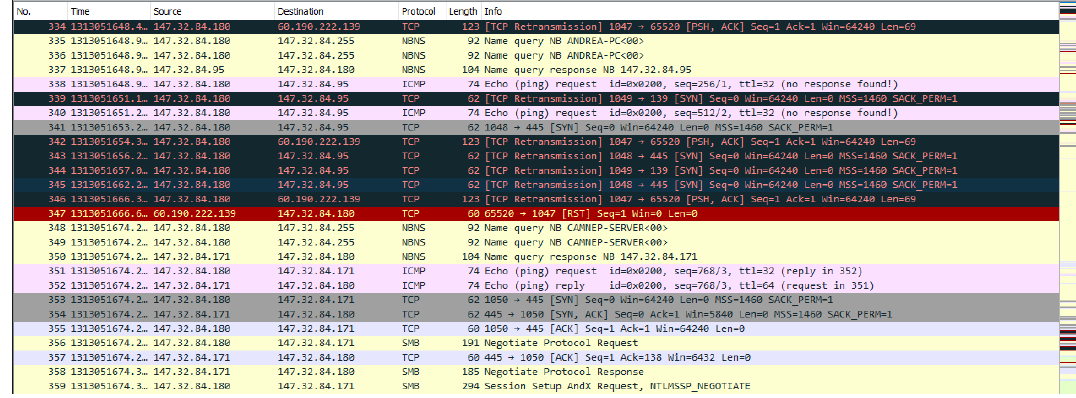
Figure 10. Network traffic captured with Wireshark.